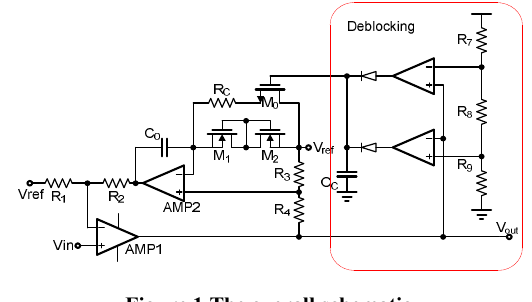
Figure 1.The overall schematic